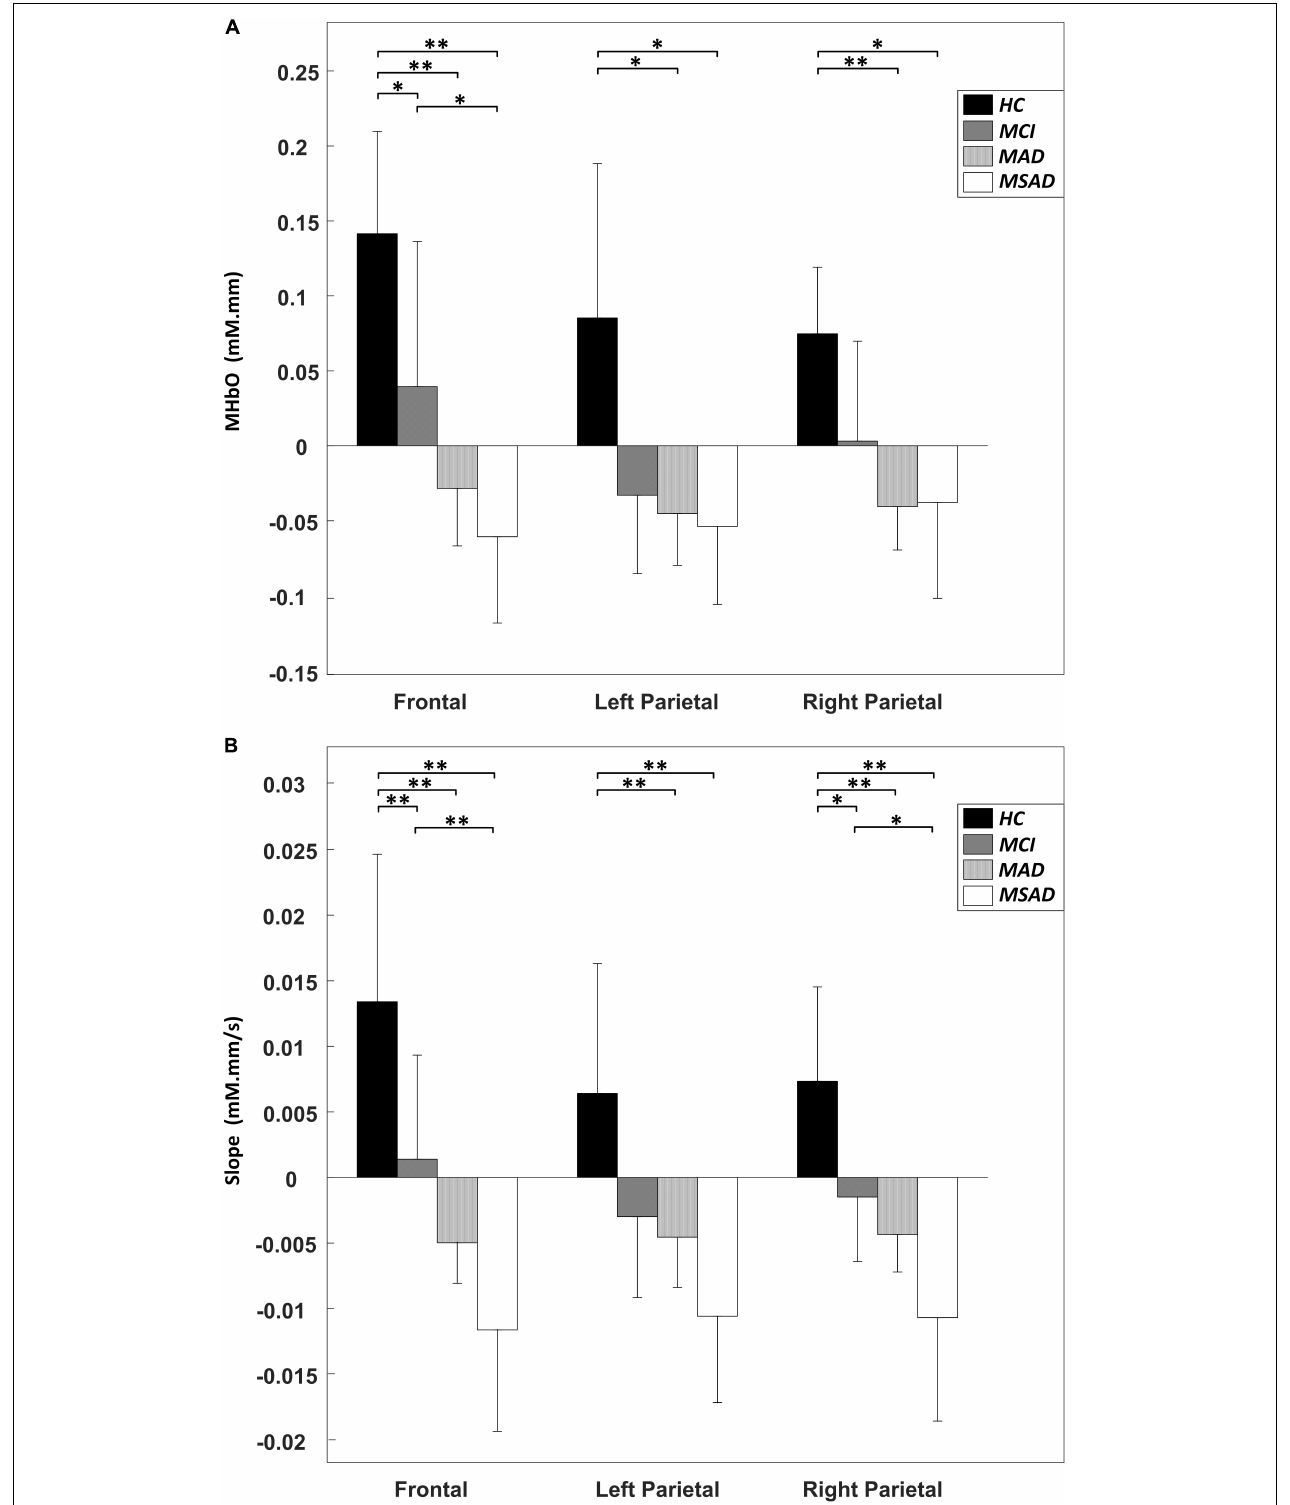
FIGURE 5 | The statistical summary of fNIRS data. (A) The mean change of HbO concentration (MHbO) in three brain regions among all groups. (B) The mean slope of HbO concentration change (SPHbO) in three brain regions among all groups. “ ∗∗ ” denotes a significant difference with Bonferroni-Holm correction, while “ ∗ ” denotes a significant difference without Bonferroni-Holm